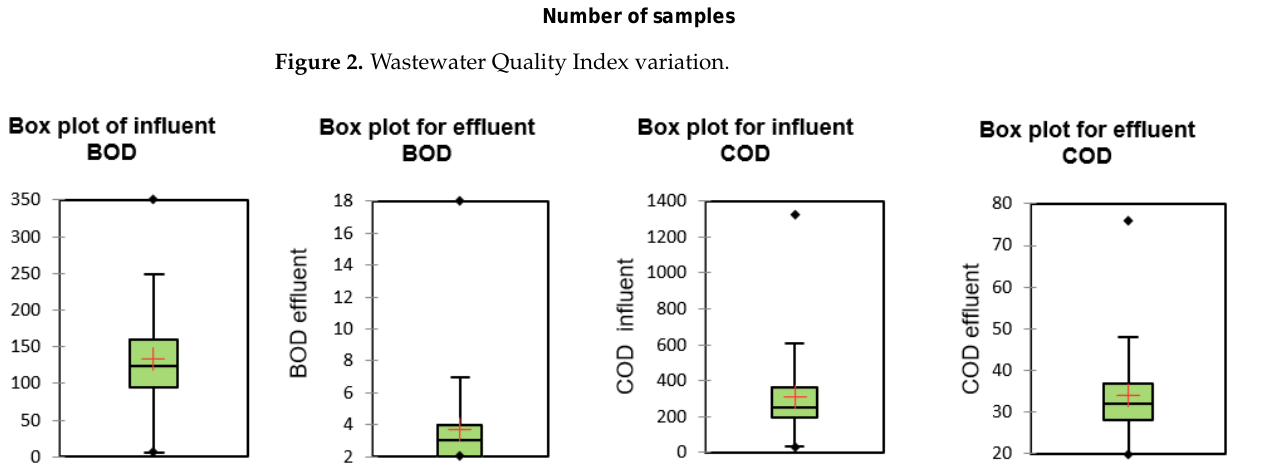
Figure 3. Boxplots of the wastewater parameters; from left to right: influent BOD, effluent BOD, influent COD, and effluent COD.